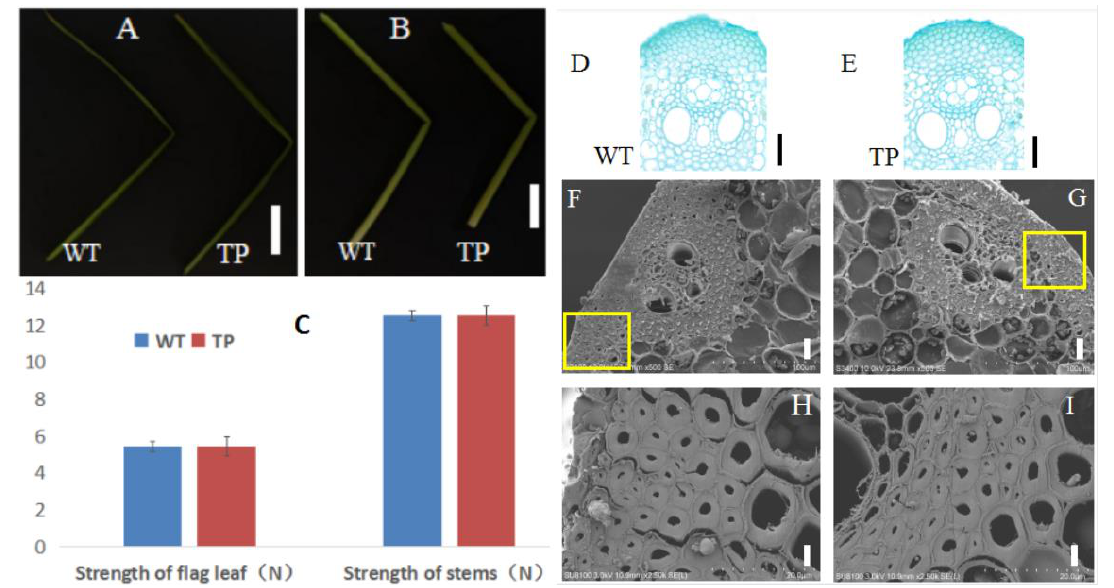
Figure 5. ( A , B ) Fractured leaves and internodes of wild-type (WT) and OsBC17 -overexpressing transgenic (TP) plants. ( A ) Flag leaves (bar = 10 cm); ( B ) internodes (bar = 2 cm). ( C ) Comparison of the mechanical strength of WT and OsBC17 -overexpressing transgenic plants. ( D , E ) Paraffin sections of stem epidermis of Pingtangheinuo wild type (WT) and OsBC17 -overexpressing transgenic (TP) plants. Bar = 50 µm. ( F – I ) Scanning electron microscopic images of stem cross sections of Pingtangheinuo wild type (WT) and OsBC17 -overexpressing transgenic (TP) plants. ( F , G ) Transverse sections of WT ( F ) and TP ( G ) stems (bar = 20 µm); enlarged images of WT ( H ) and TP ( I ) mechanical tissue (bar = 4 µm). The yellow boxes in ( F,G ) are enlarged to show ( H,I ), respcetively.